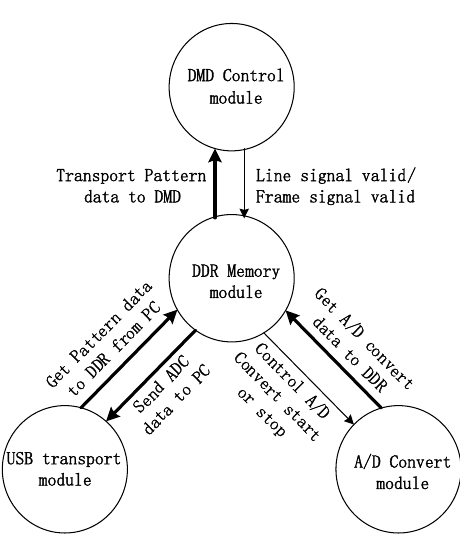
Figure 6. The relation schema of the main modules.